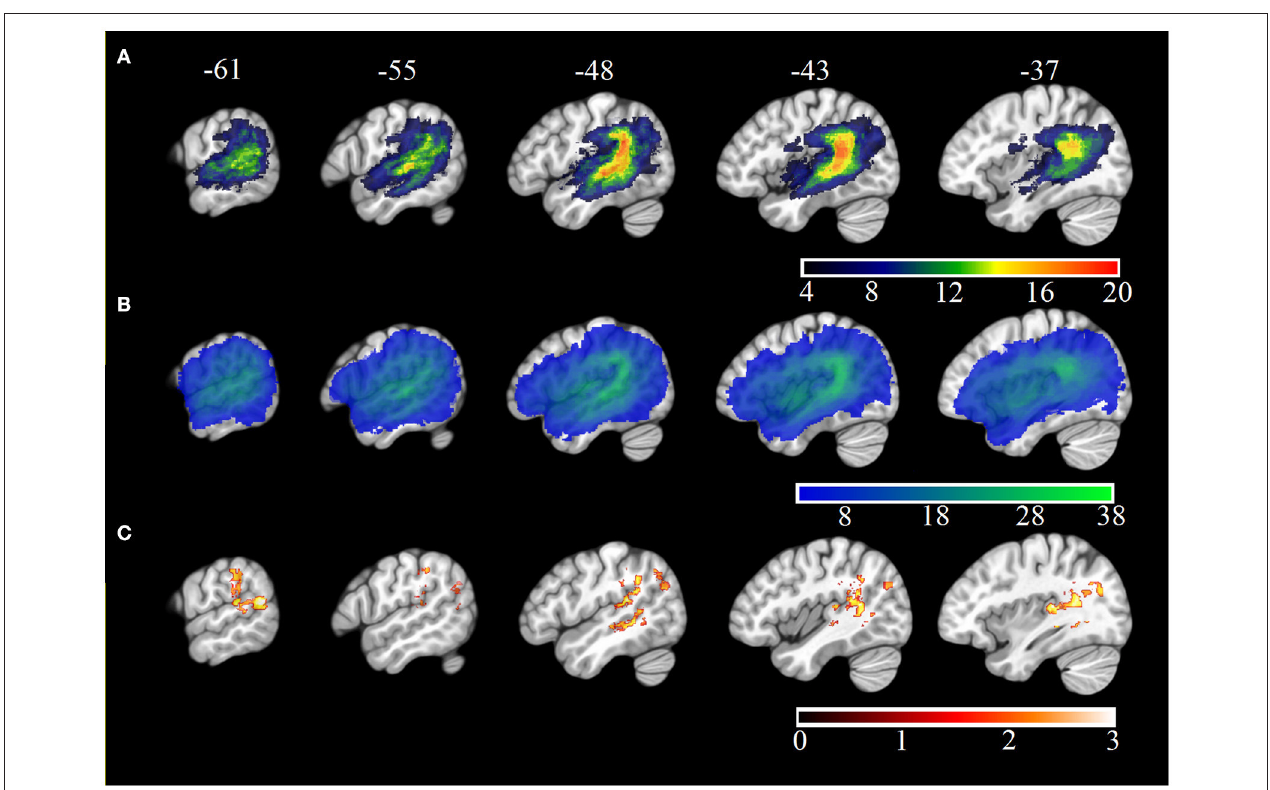
FIGURE 1 | MNI X-coordinate displayed above. (A) Lesion overlap map for Jargon aphasia participants for whom imaging was available. Color bar indicates number of individuals with lesion at each voxel. (B) Lesion overlap map for all aphasia participants for whom imaging was available. Color bar indicates number of individuals with lesion at each voxel. (C) VLSM results (threshold ≤ 0.05) showing voxels significantly associated with jargon score. Color bar indicates